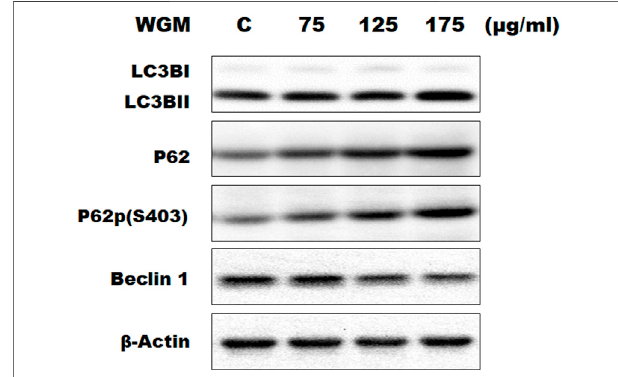
FIGURE 4 | Effects of WGM extracts on the expression of autophagy- related genes in Hep3B cells. The effects of WGM extracts on the expression of autophagy-related genes were analyzed by Western blotting. Cells were treatedwithvehiclealone(C)orwith75,125or175 μ g/mlWGMextracts for24 h.ProteinsampleswereanalyzedbySDS-PAGE(10%forbeclin1,p62 and p62p(S403), 12% for β -actin and 15% for LC3B), and then probed with primary antibodies followed by secondary antibodies. Results are representative of three independent